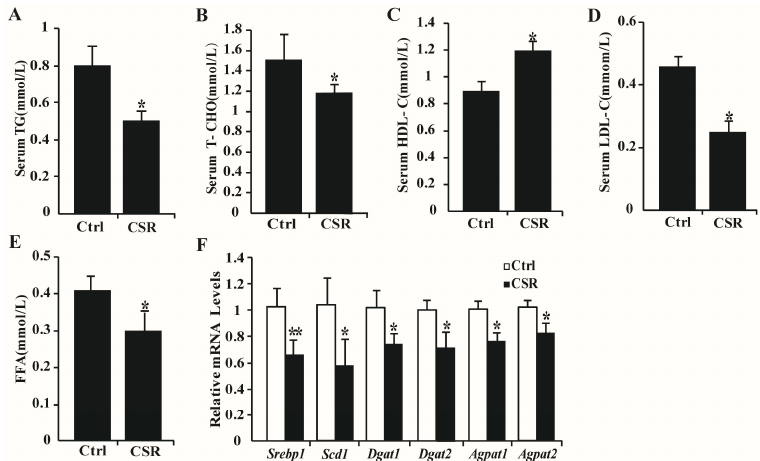
Figure 3. Metabolomic analysis of chronic sleep restriction: ( A ) Typical 1 H NMR spectra (600 MHz) obtained from serum of control ( a ) and CSR rats ( b ) after sleep deficiency. The keys for the metabolites were given in Table S1. Cross-validated OPLS-DA scores plots ( B ); and the corresponding loadings plots ( C ) from 1 H NMR spectra of control and CSR rats. Black squares = control group; red dots = CSR group. (OPLS-DA: Q 2 = 0.493; CV-ANOVA: p = 0.029). Keys: 1, lipoproteins; 2, isoleucine; 3, valine; 4, choline; 5, phosphorycholine; 6, triglycerides; ( D ) The relative quantitative ratios of significantly changed metabolites in ( C ); ( E ) Fatty acid compositions obtained from GC-FID/MS analysis of serum. ToFA: total fatty acids; SFAs: saturated fatty acids; UFAs: unsaturated fatty acids; MUFAs: monounsaturated fatty acids; PUFAs: polyunsaturated fatty acids. White squares = control group; black squares = CSR group. * p < 0.05, ** p < 0.01 vs. control. n = 10.